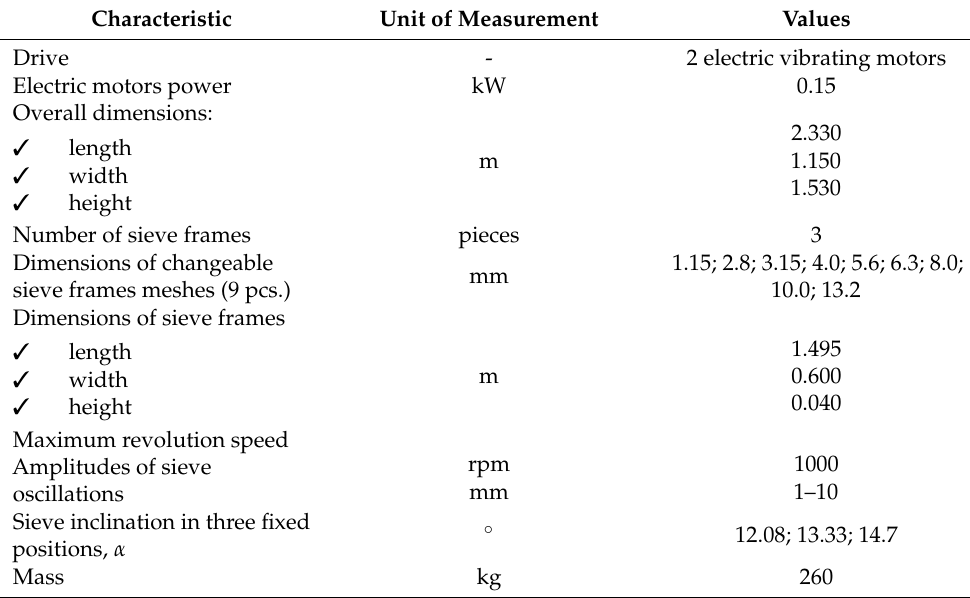
Table 1. Main technical characteristics of the plant sorter.